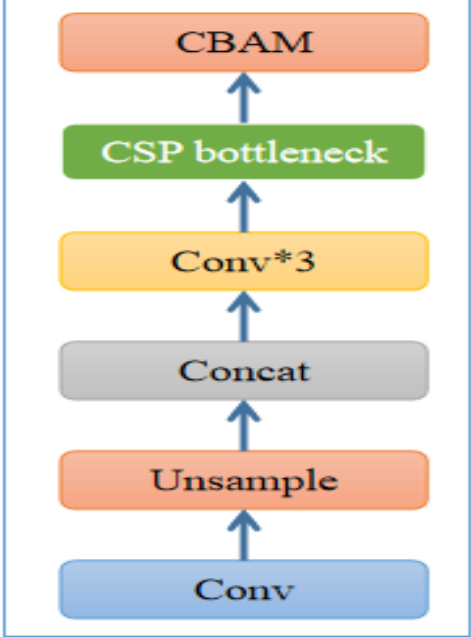
Figure 6. The CBAM model was added to each basic block, which integrates the output features immediately after the CSP bottleneck. Among them, Conv * 3 means that three convolution layers are superimposed together.